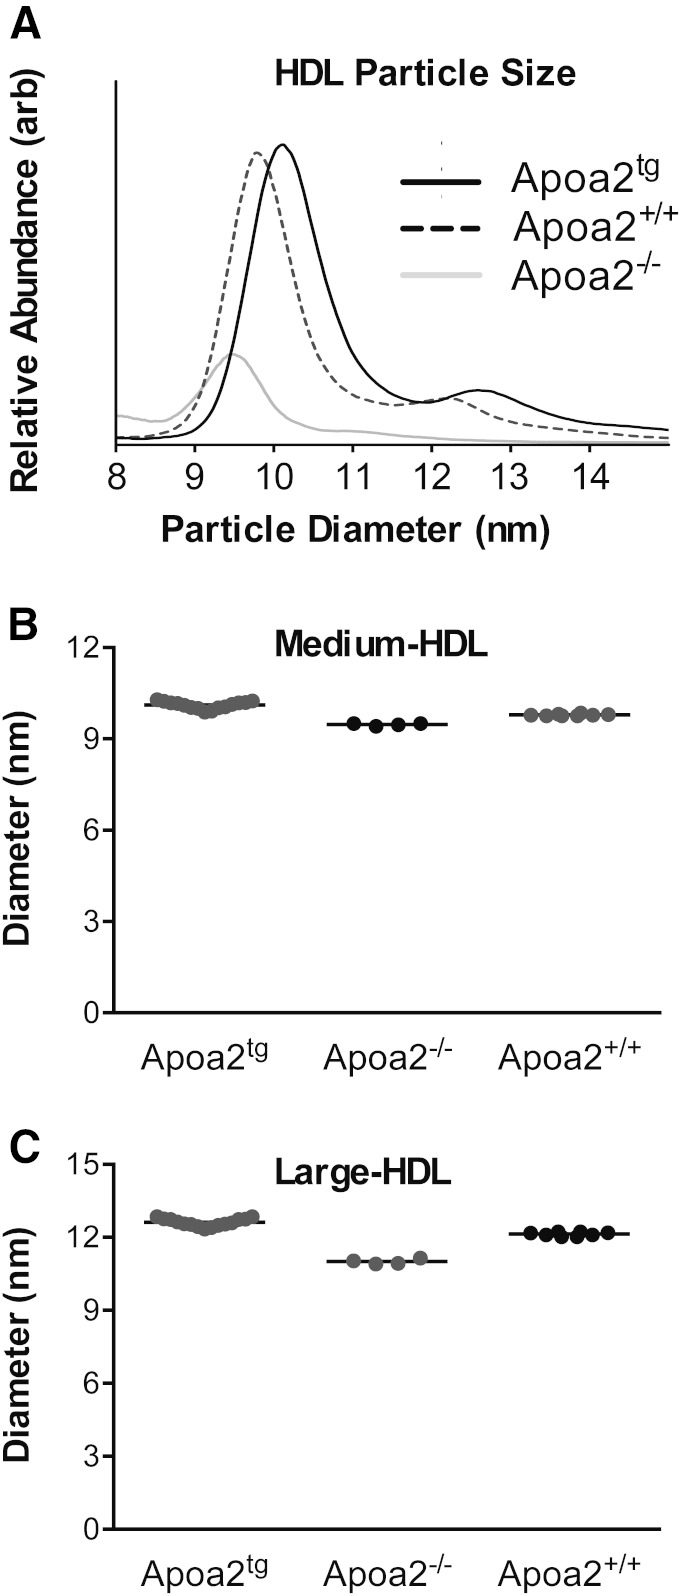
HDL particle size and abundance in wild-type mice, Apoa2−/− mice, and human APOA2 transgenic mice. Relative HDL particle abundance (A) and size (B, C) were determined by calibrated IMA in HDL isolated by ultracentrifugation of the plasma of Apoa2tg mice (n = 15), Apoa2+/+ mice (n = 8), and Apoa2−/− mice (n = 4). arb, arbitrary units.